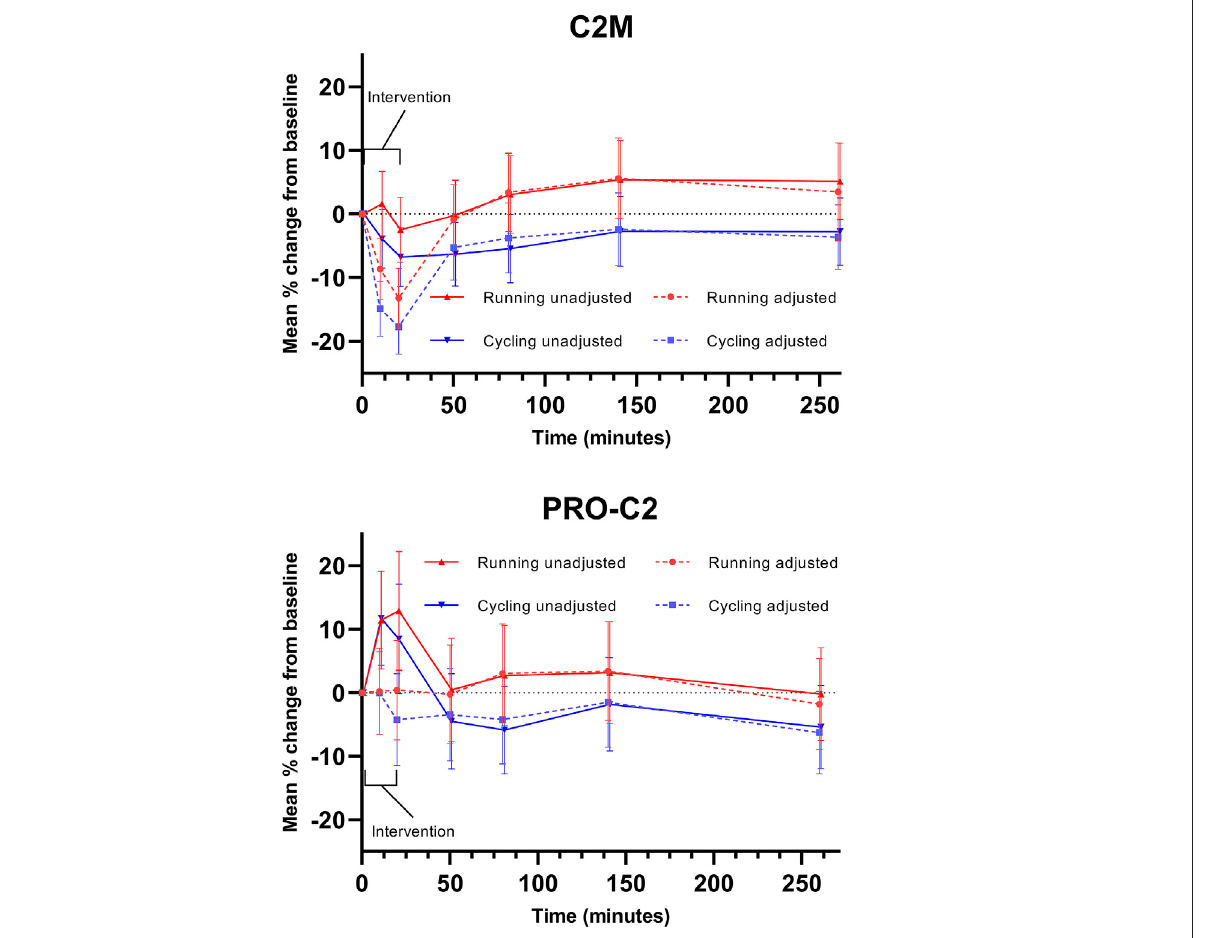
FIGURE 3 | Adjustment in biochemical markers. Serum markers of type II collagen degradation (C2M) and repair (PRO-C2) are displayed. Error bars represent a 95% con fi dence interval.